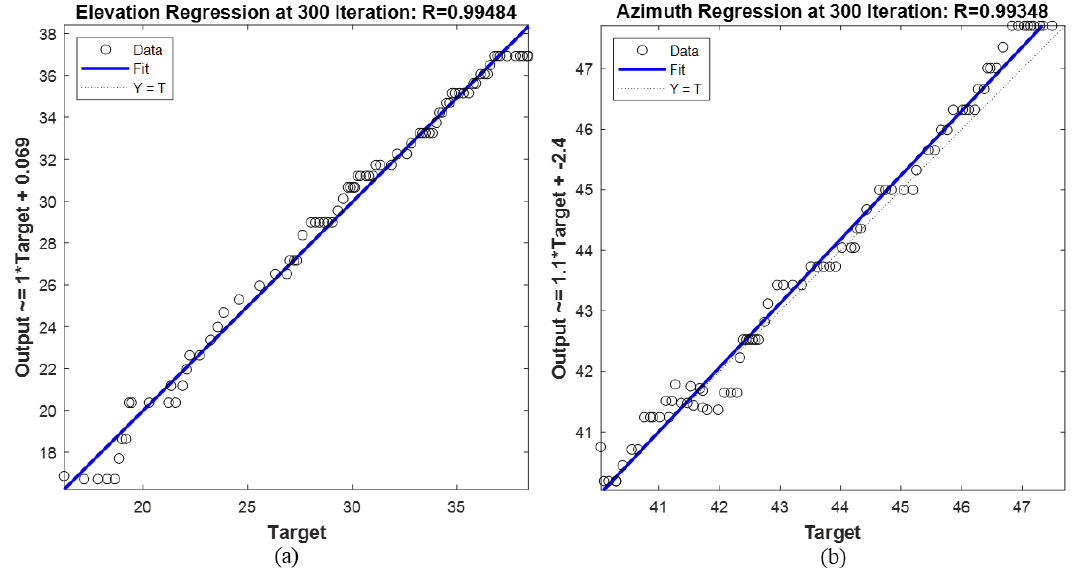
Figure 6. Regression performance for estimating lightning map at 100 iterations: ( a ) elevation regression line; ( b ) azimuth regression line.